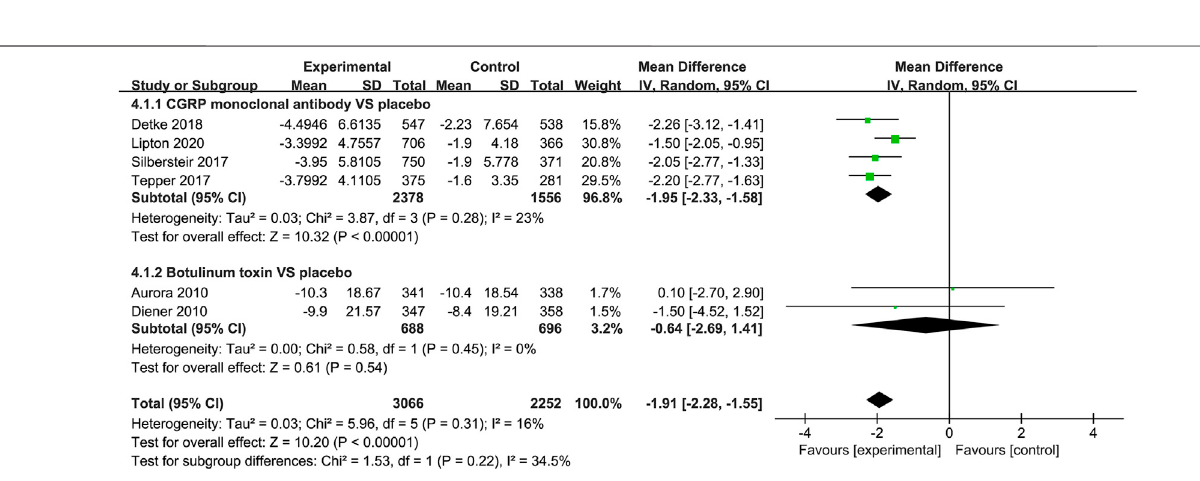
Impact Test 6 (HIT-6) score (CGRP monoclonal antibody vs.